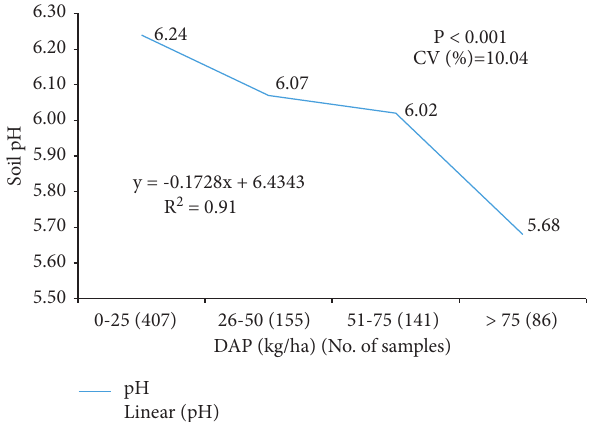
Figure 3: pH level on crop fields with different rates of urea fertilizer.